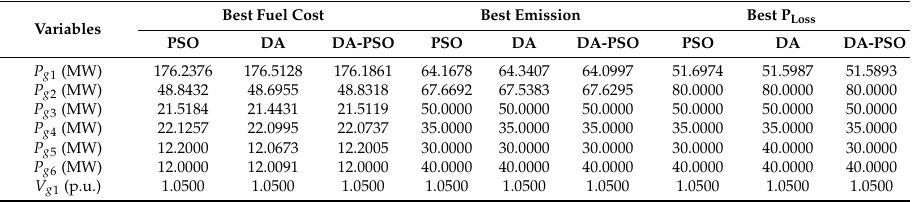
Table 1. Comparison of the simulation results from particle swarm optimization (PSO), dragonfly algorithm (DA), and DA-PSO for IEEE 30-bus